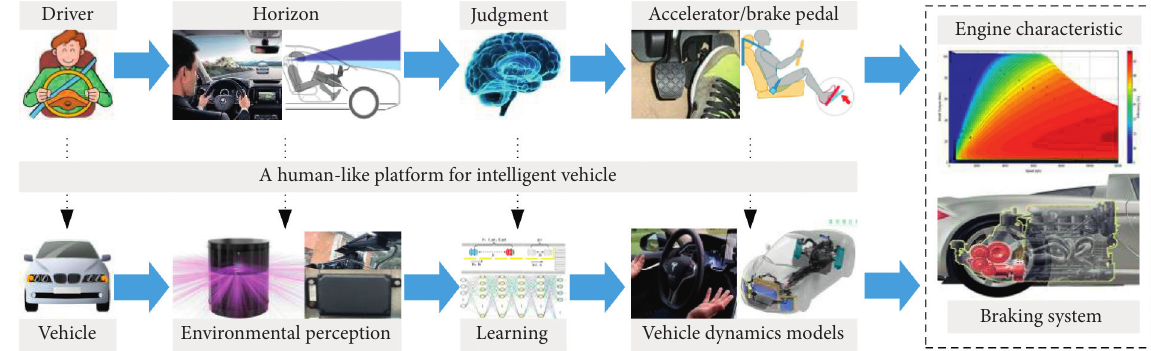
Figure 1: A human-like platform for intelligence